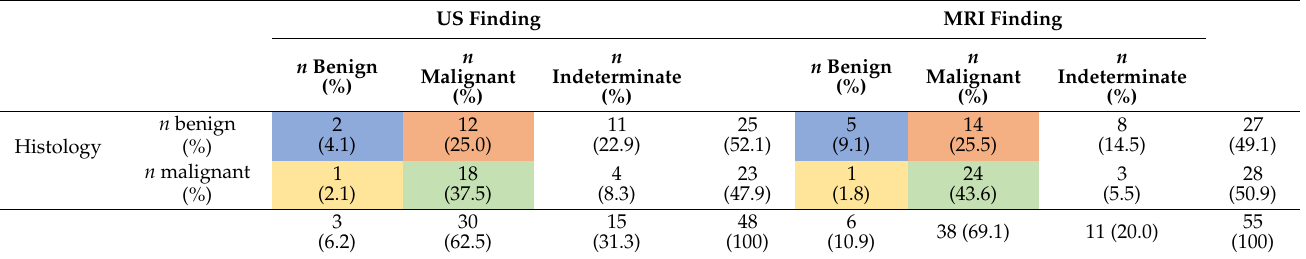
Table 1. Rate of true negative , false negative , false positive , true positive and indeterminate preoperative ultrasound (US) and magnetic resonance imaging (MRI) findings regarding histopathol- ogy results.